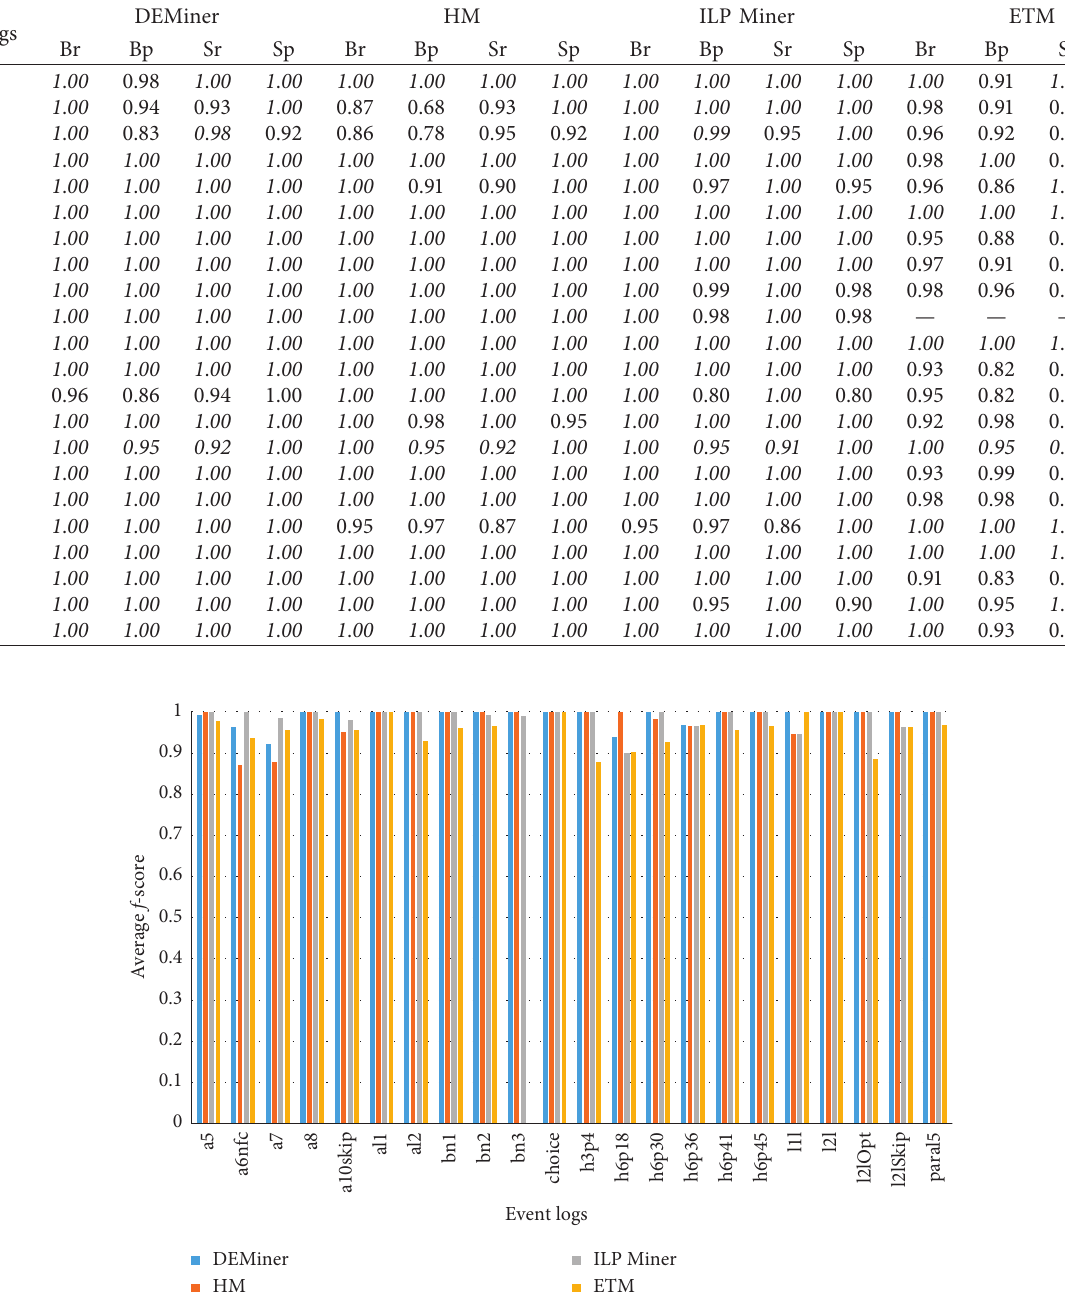
Table 5: Comparison of four algorithms’ performance on 22 event logs without noise.